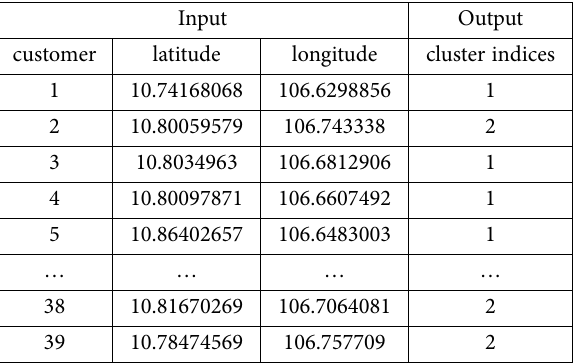
Table 2. Input-output of the classical k -means